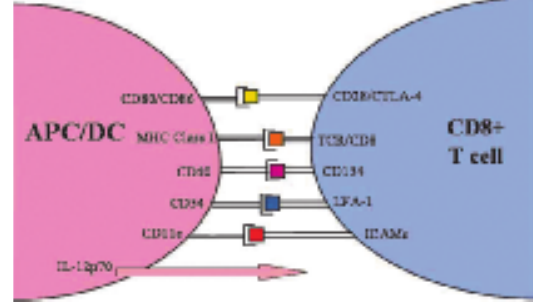
Antigen Presenting Cells (APC) activate T cells. APC, like B cells, macrophages and DC, express an array of costimu- latory molecules in addition to high levels of MHC class I and II. This enables APC to strongly activate T cells, assisted by additional molecules like adhesion molecules and synthesis of cytokines like IL-12